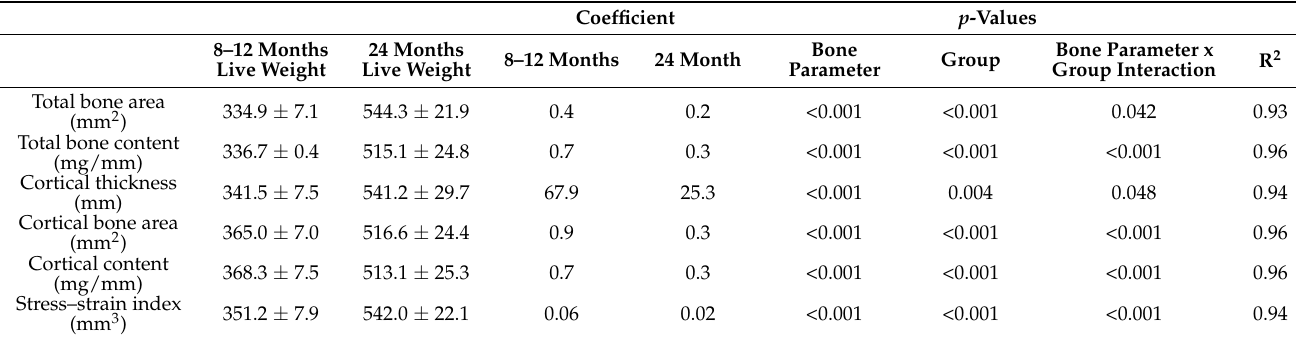
Table 4. Least squared means and standard error for live weight adjusted for each bone parameter in the metacarpus of control steers (8–12 months) and 24-month-old steers from cohort three. Regression coefficient for each group is presented with the interaction of bone parameter and group being